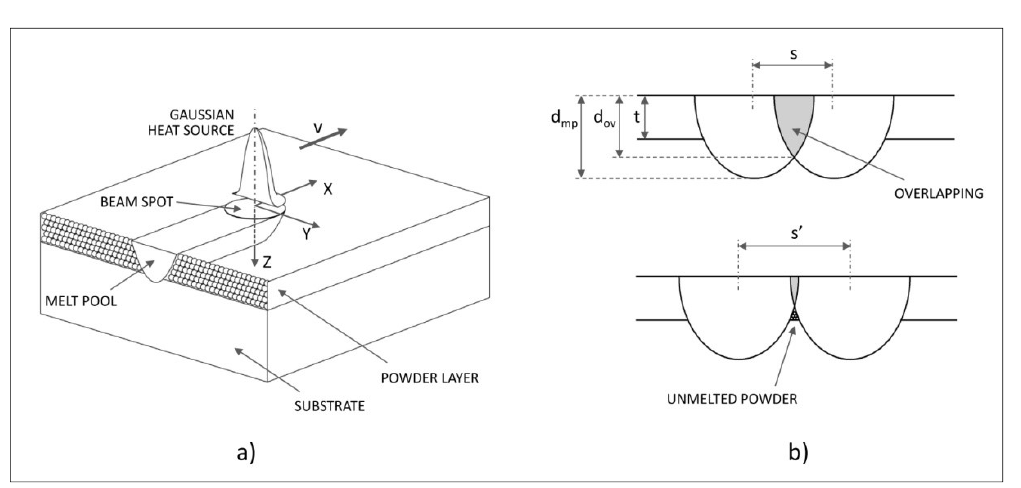
Figure 2. Electron beam powder bed fusion (EB–PBF) process: ( a ) Basic scheme of electron beam scanning; ( b ) Effect of scan spacing on overlapping condition.